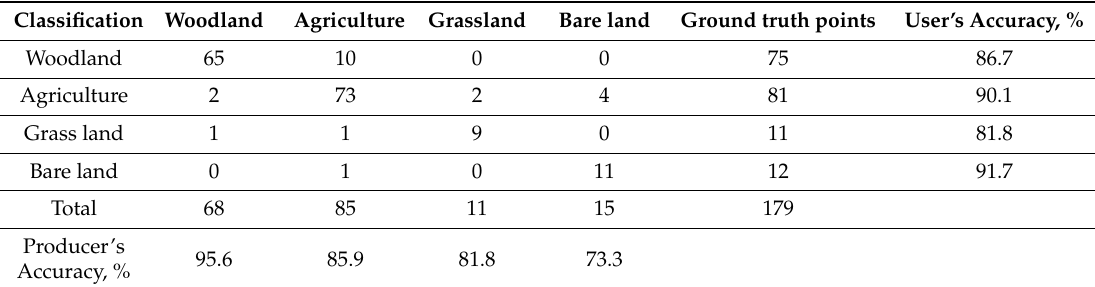
Table 3. Error matrix of classification accuracies for